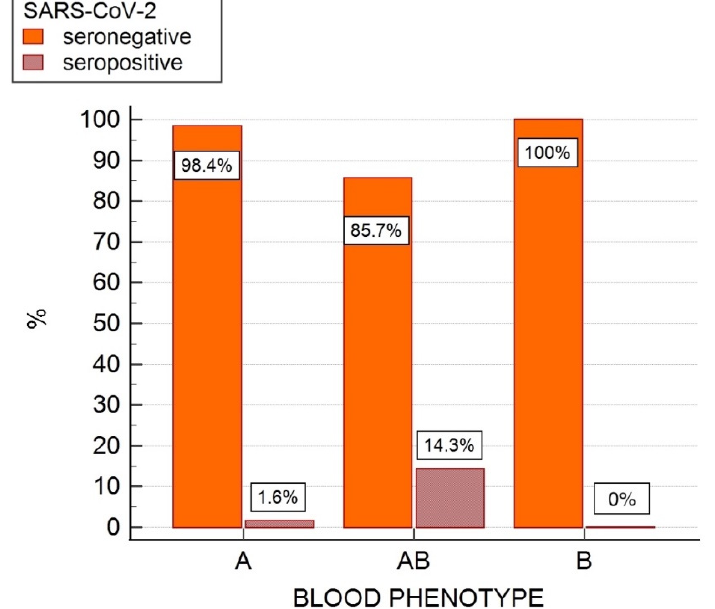
Figure 3. Frequency bar chart showing AB blood group system blood type prevalence (%) in SARS- CoV-2 seropositive and seronegative cats in a feline population of 215 cats from northern Italy evaluated for an association between blood phenotype and serostatus for SARS-CoV-2 antibodies. All 148 oropharyngeal and rectal swabs collected from the shelter and stray colony cats tested negative for SARS-CoV-2 RNA.